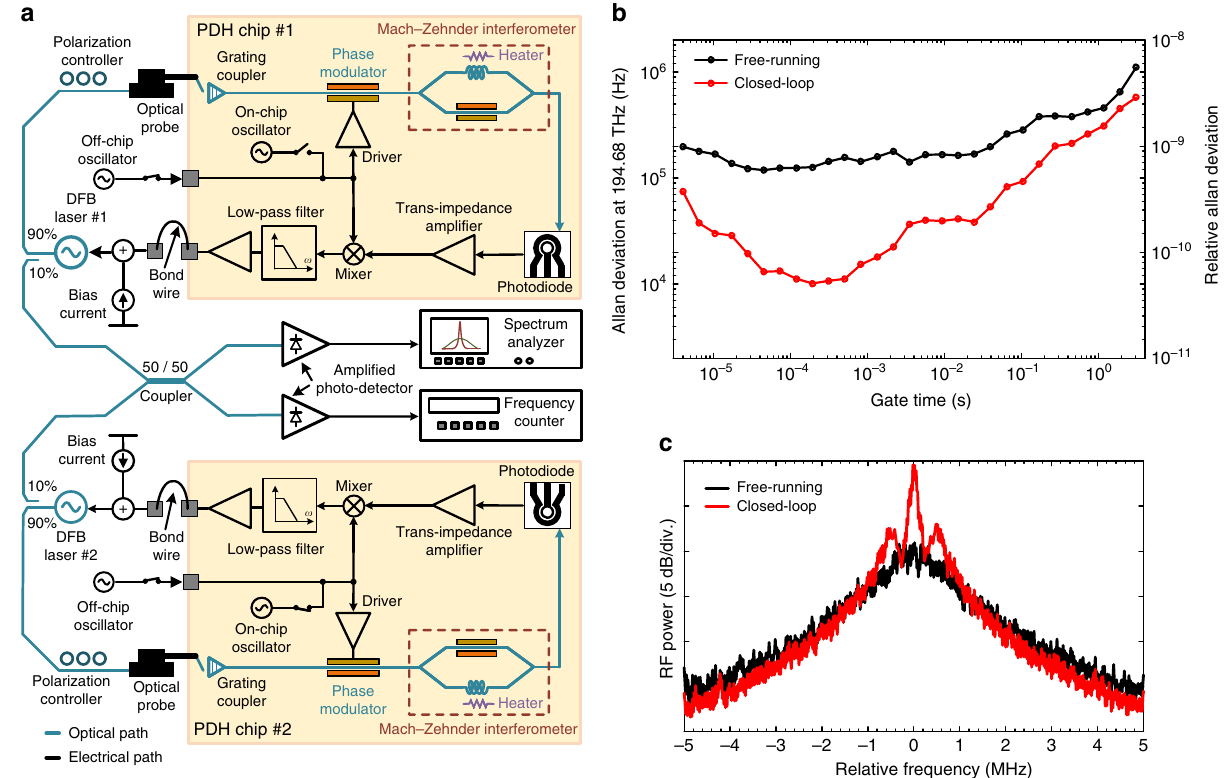
Fig. 7 Allan deviation measurement. a The Allan deviation measurement setup. Two Alcatel 3CN00325CW distributed feedback (DFB) lasers were independently Pound − Drever − Hall (PDH) stabilized using two PDH chips. The outputs of two stabilized lasers were combined using a 50/50 coupler and photo-detected. The photo-current was ampli fi ed and used to measure the relative Allan deviation and the spectrum of the beat note. b The measured relative Allan deviation of the beat note between two DFB lasers is shown for free-running and independently PDH stabilized cases. At a gate time of 200 μ s, the relative Allan deviation of the beat note is decreased from 6.5 ´ 10 − 10 to 5.2 ´ 10 − 11 when the PDH stabilization was engaged. In this case, assuming the two DFB lasers are equivalent, a relative Allan deviation reduction from 4.6 ´ 10 − 10 to 3.6 ´ 10 − 11 is estimated for each PDH stabilized laser. c The radio frequency (RF) spectrum of the beat note between two DFB lasers for free-running and closed-loop